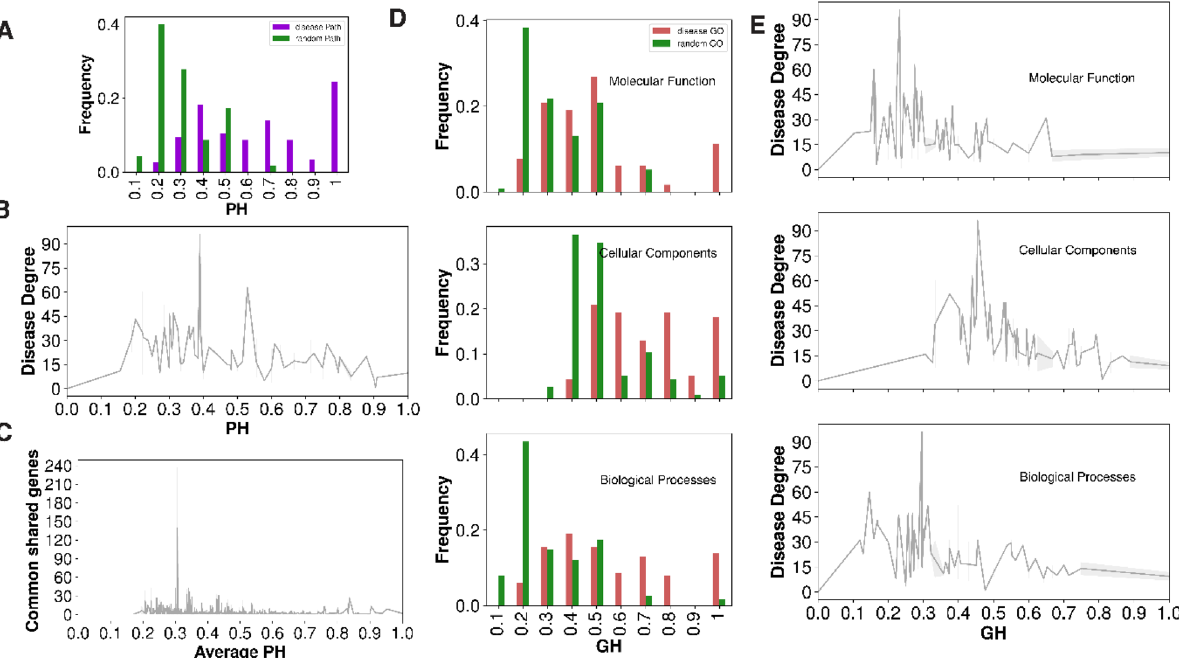
Figure 3. Diseasome properties: ( A ) A distribution of the molecular pathways homogeneity (PH) of individual diseases in cardiomyopathy-centric diseasome. Purple bars represent the actual diseasome, and the green bars show the random control calculated for each disease by randomly choosing the same number of genes. The PH is formulated as the maximum possible fraction of genes associated with the same molecular pathway in individual disease. ( B ) A lineplot of disease degree versus PH value distribution in the diseasome. ( C ) The distribution of number of common genes between two disease phenotype and their average PH value in the cardiomyopathy-centric diseasome. ( D ) The GO homogeneity measure of cardiomyopathy-centric diseasome genes for all GO categories—cellular component (CC)(Middle), biological process (BP) (Bottom), and molecular function (MF) (Top). The GH for each disease term was calculated like the PH analysis. Red bars represent the actual diseasome histogram, and the green bars show the random control. ( E ) A lineplot of disease degree and GH value distribution for each GO category in the